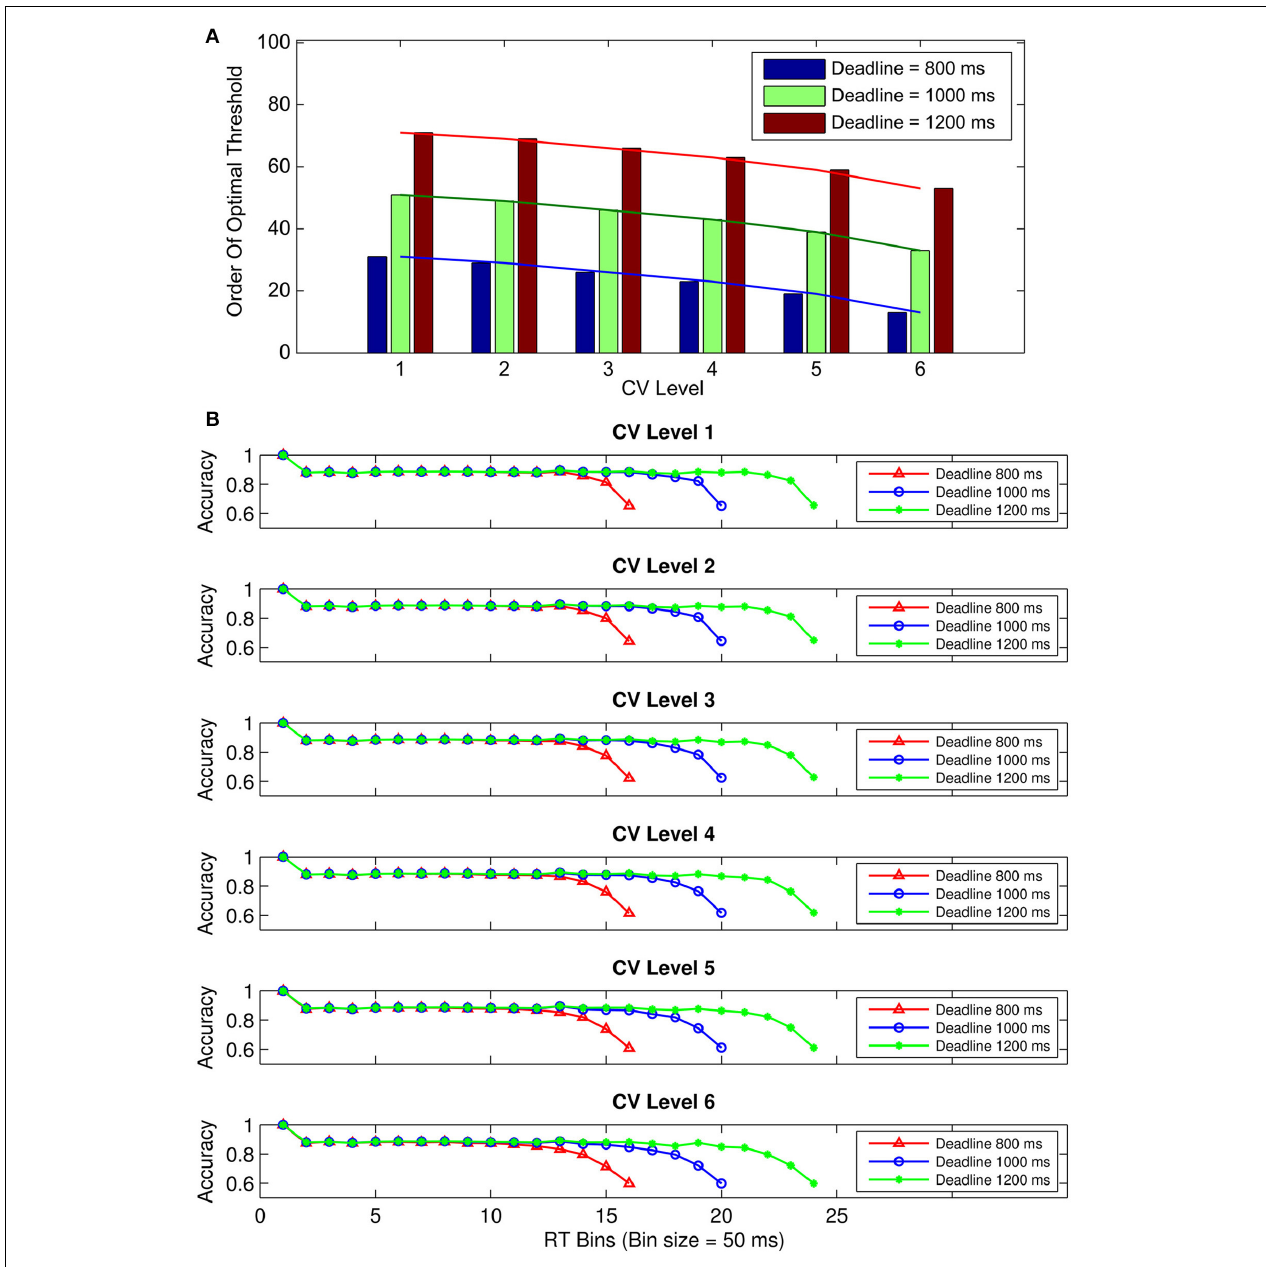
FIGURE 4 | (A) Bar graphs depicting the order of the optimal threshold collapse trajectories (out of 101 thresholds with 0.01s increments) selected from the family of exponential decline functions for six hypothetical levels of timing uncertainty. Lines connect the bars. (B) Conditional accuracy curves for the six CV conditions, shown separately